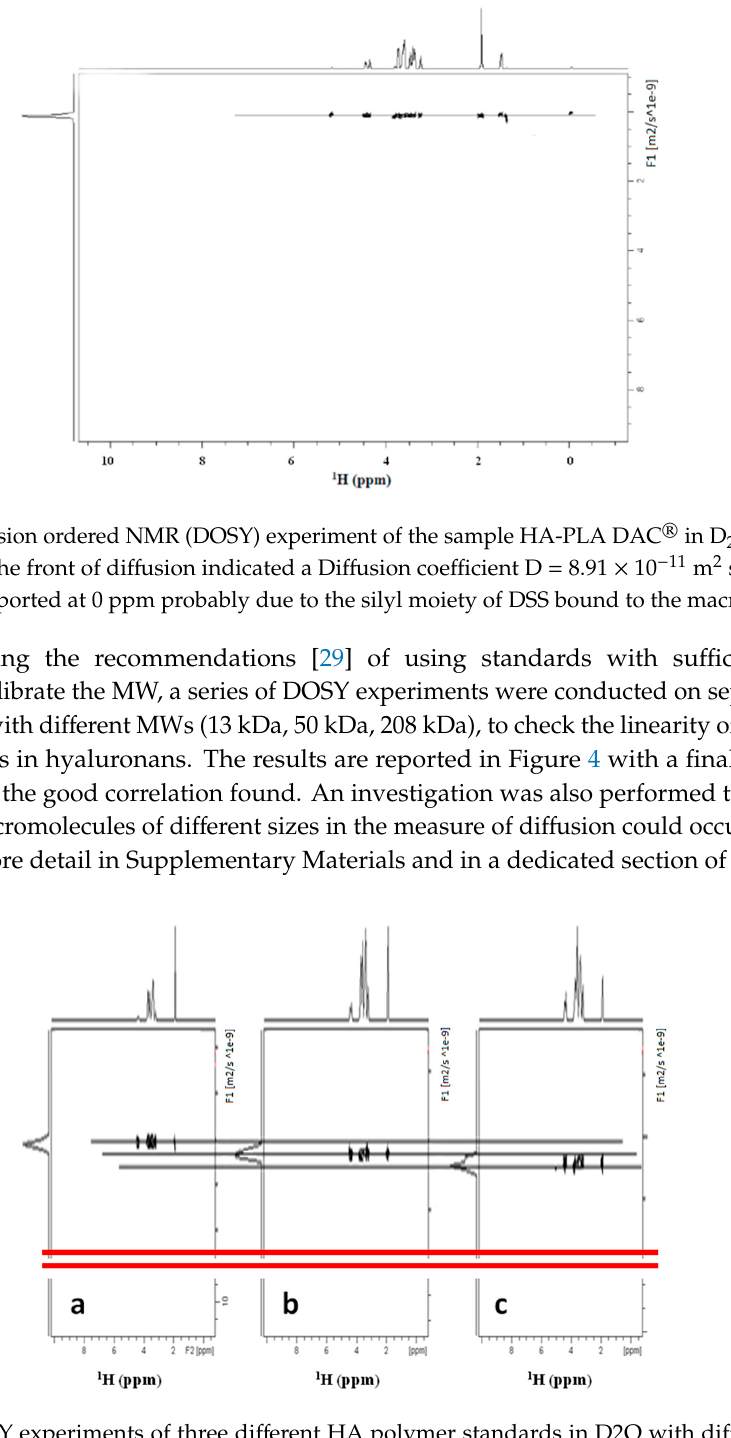
Figure 5. Calibration curve of the diffusion coefficient of fragments of HA with different MWs. 13 kDa; 50 kDa; 208 kDa. The diffusion of the trace of protonated water molecule (1% in D 2 O) is also included with a correlation of 0.999. Moreover, a detailed study of the possible interferences between these types of polymers was carried out using a mix of the 13 kDa with the 50 kDa ones and of the 13 kDa with the 208 kDa standard samples. In addition, these results are reported in Supplementary Materials and in the related paragraph in the Discussion section. 3.2. Stability Studies of HA-PLA DAC ® Sterilized